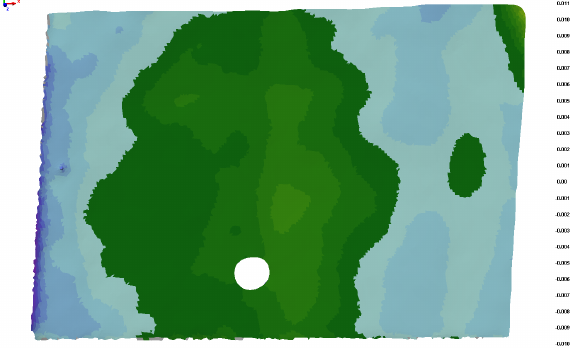
Figure 4. Color-coded deviation from the best-fitting plane of the same same map shown in Fig. 3, after the application of a low-pass filter leaving the systematic 3D distortion only. The color map is the same of Fig. 3.